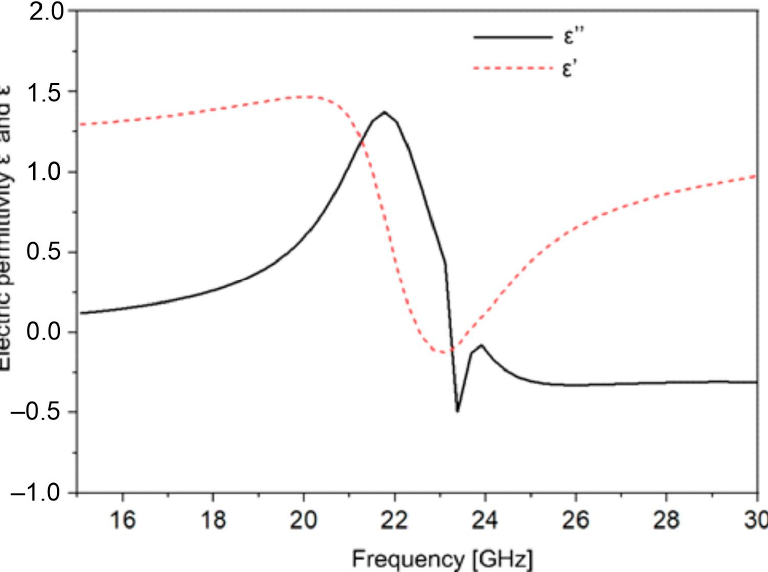
Figure 3. Frequency characteristics of the composite electric permittivity of the tested SRR structure ( ε′ and ε″ , the real and imaginary parts of the effective electric permittivity, respectively).